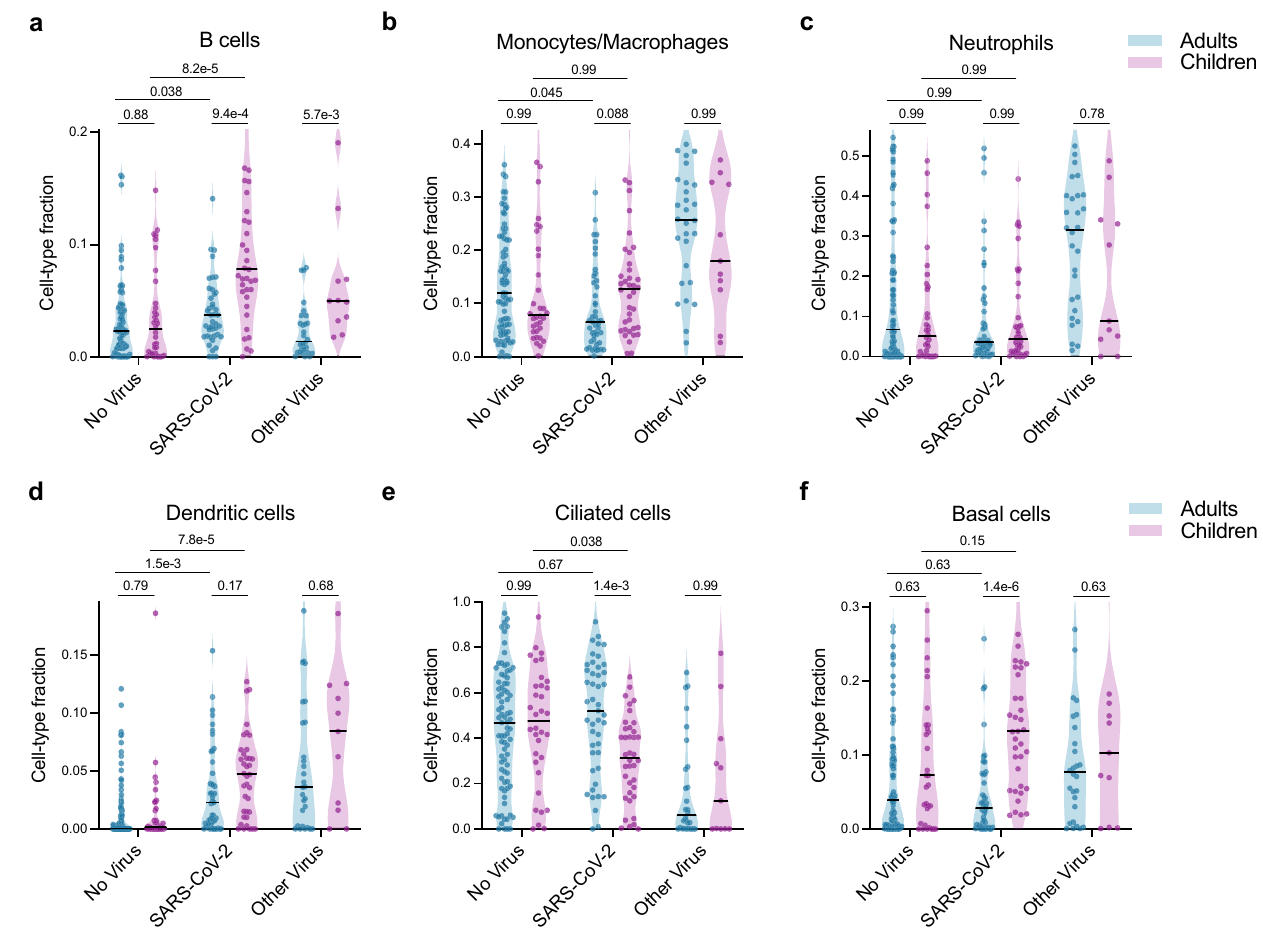
Fig. 3 Cell-type proportion differences between children and adults. a – f In silico estimation of cell-type proportions in the bulk RNA-sequencing using single-cell signatures. Color indicates the age cohort. Black lines denote the median. The y-axis in each panel was trimmed at the maximum value among all groups of 1.5*IQR above the third quartile, where IQR is the interquartile range. For each cell type, we formally compared each viral status group between the two age cohorts as well as the No Virus and SARS-CoV-2 groups within each age cohort. Pairwise comparisons were performed with a two-sided Mann-Whitney test followed by Holm ’ s correction for multiple testing. Adults-No Virus n = 81, Adults-SARS-CoV-2 n = 45, Adults-Other Virus n = 28, Children-No Virus n = 34, Children-SARS-CoV-2 n = 38, Children-Other Virus n = 11. Complete results are provided in Supplementary Data